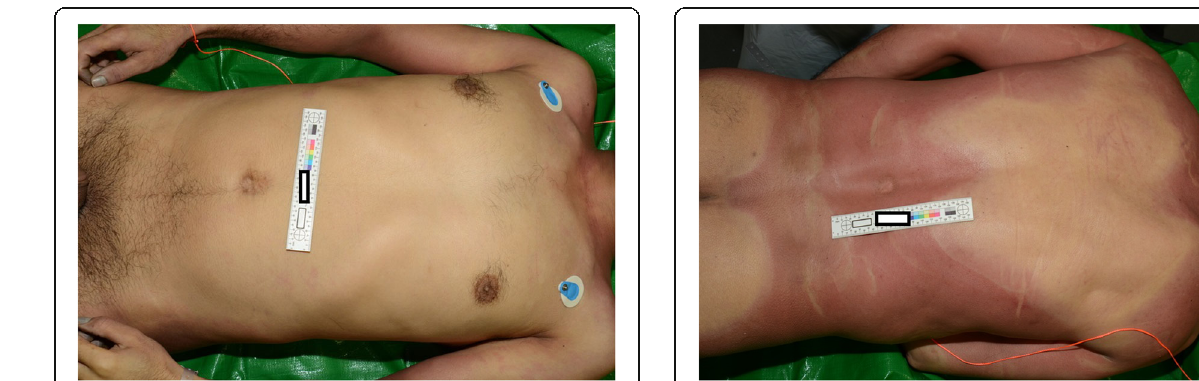
Fig. 3 View of the back and the scar on the back